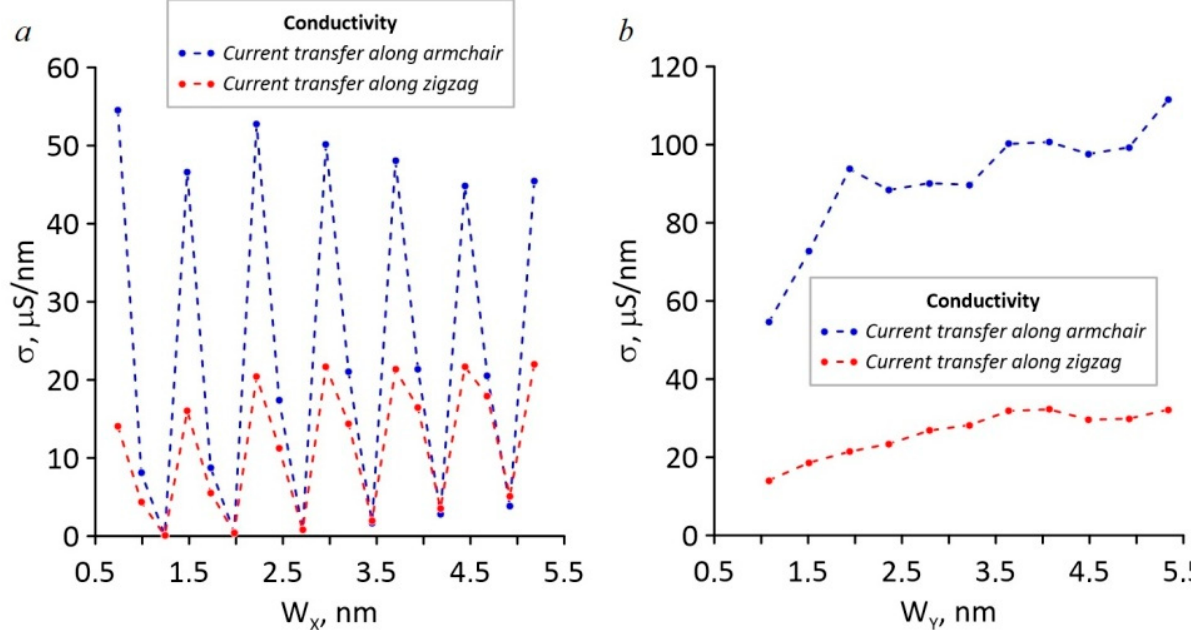
Figure 6. The dependency of the specific conductivity of HG on the neck width during an increase along the zigzag ( a ) and the armchair directions ( b ).